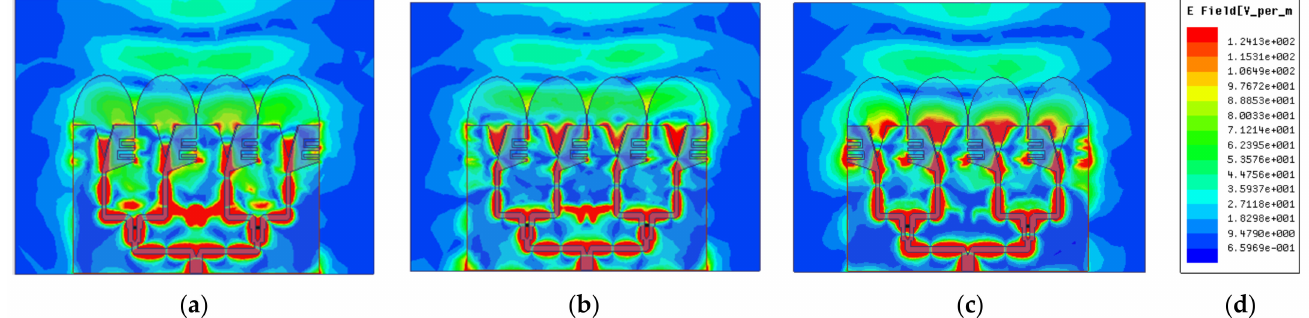
Figure 15. E-field distribution of the proposed array with DGS at ( a ) 9 GHz, ( b ) 10 GHz, and ( c ) 11 GHz and ( d ) relative value of electric field